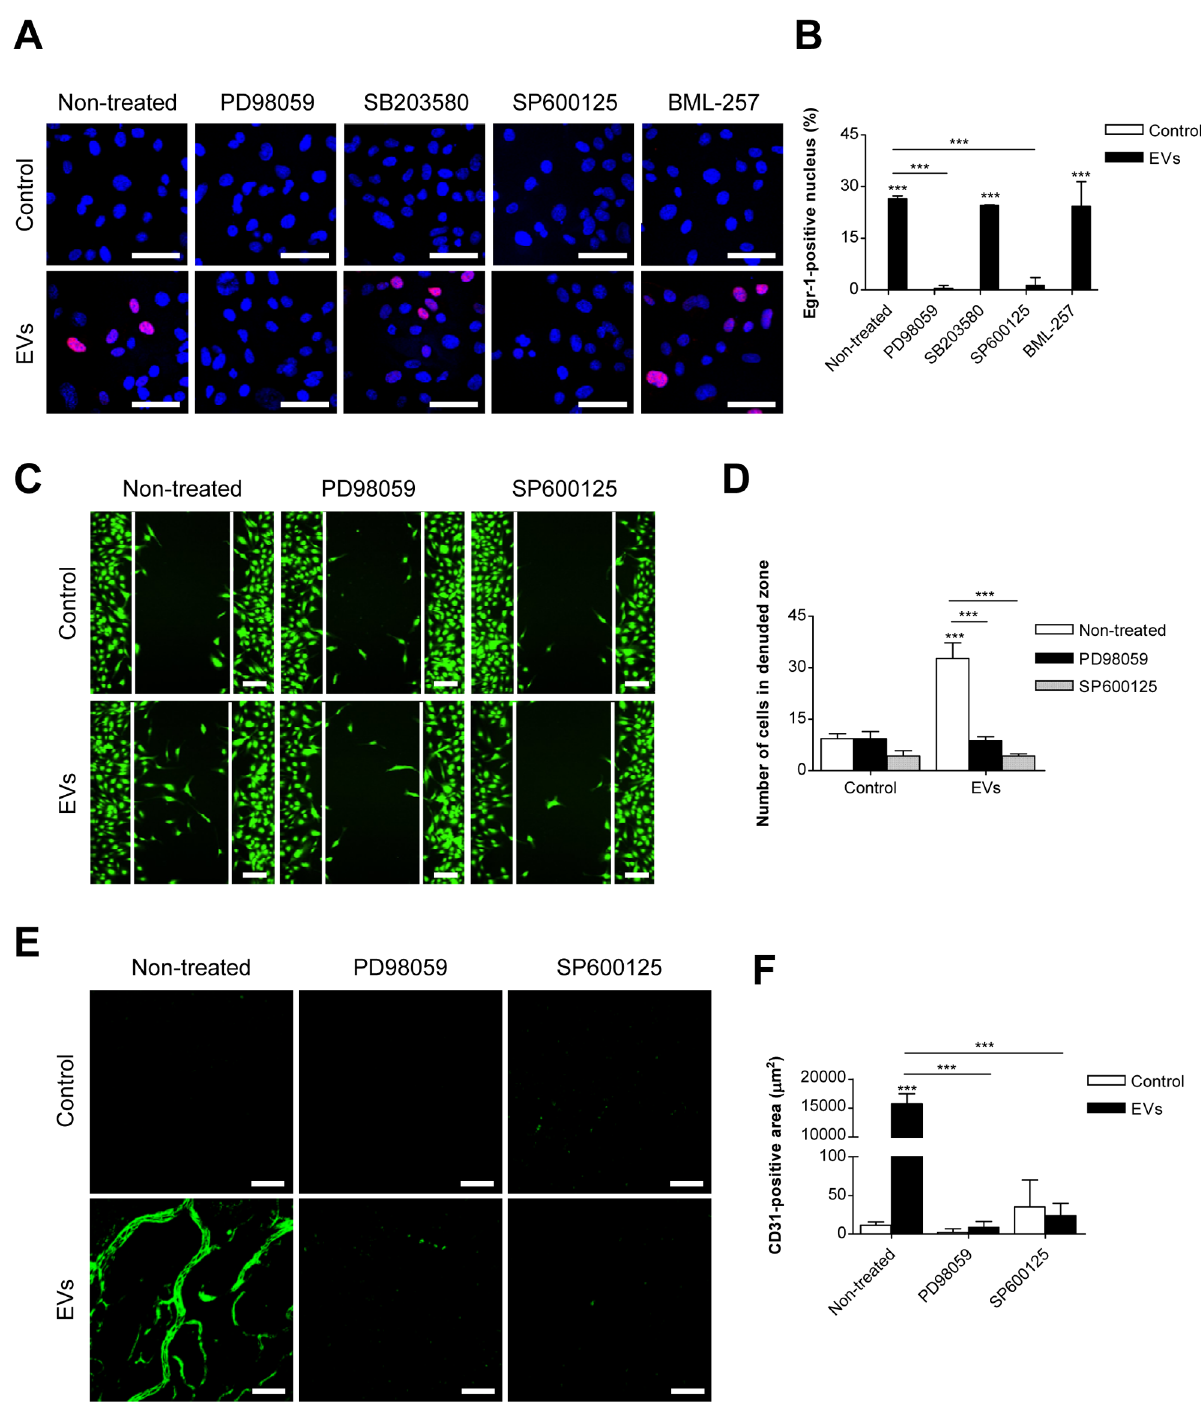
Fig. 4. Role of ERK1/2 and JNK signaling pathways in SW480-derived EV-mediated endothelial cell migration. (A, B) HMEC-1s were pretreated with signaling inhibitors for 1 h and then stimulated for 1 h with SW480-derived EVs (1 m g/mL). Nuclear translocation of Egr-1 protein was analyzed using confocal microscopy (n 5 3). Nuclei and Egr-1 proteins were stained with Hoechst (blue) and anti-Egr-1 antibody (red), respectively. Co-localized fluorescence signals (purple) indicate the translocation of Egr-1 into the nucleus. Representative photographs are shown in panel A. The percentage of Egr- 1-positive nuclei was determined by measuring the number of cells with nucleus colocalized signals over total cells (B). (C, D) Confluent HMEC-1s were scratched and treated with SW480-derived EVs (1 m g/mL) in the presence or absence of signaling inhibitors; then the number of migrated cells in